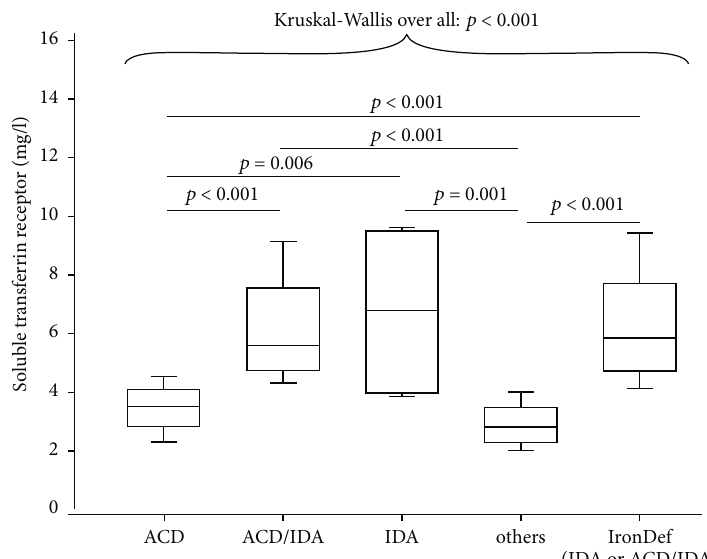
Figure 1: Serum levels of soluble transferrin receptor in anemic patients with RA demonstrated as box plots with the 90th, 75th, 50th (median), 25th, and 10 th percentile. IDA: iron de fi ciency anemia; ACD: anemia of chronic disease. Table 2: Sensitivity, speci fi city, and predictive values of sTfR and standard parameters of iron status alone and in combination for the diagnosis of IDA or ACD/IDA ( N = 42 ) in the whole sample ( N = 116 ).